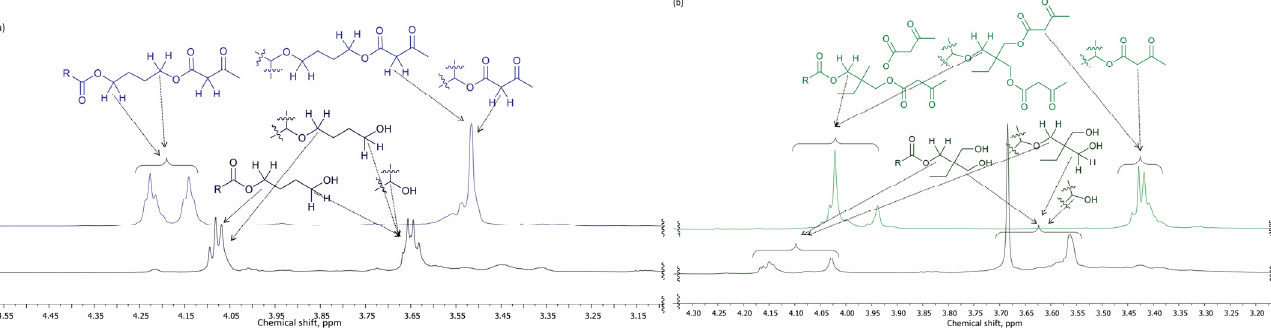
Figure 6. 1 H-NMR of TOFA and E IR TOFA (500 MHz, CDCl 3 ).